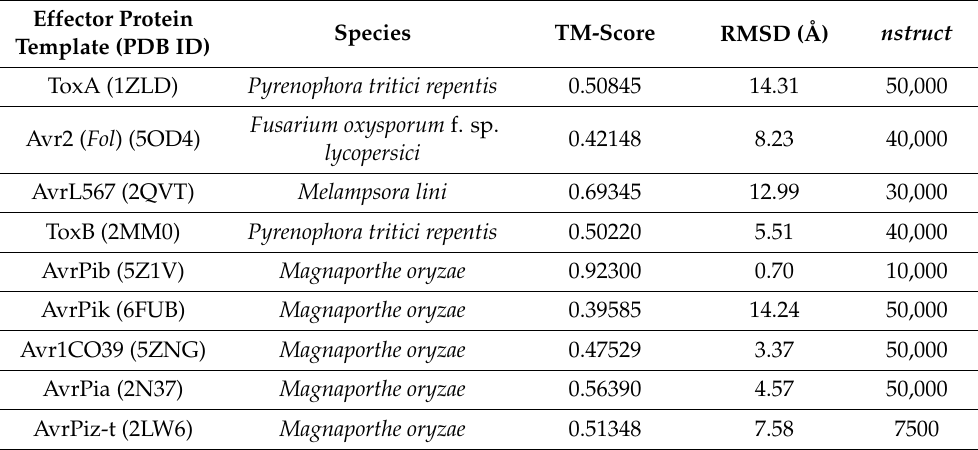
Table 1. Characteristics of the best structural models obtained with Rosetta ab initio modelling for ToxA-like and MAX effector